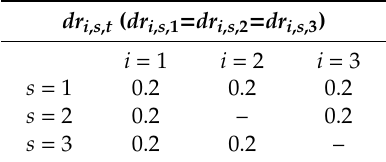
Table A6. Discount rate at any time period t (considered here the same for any time